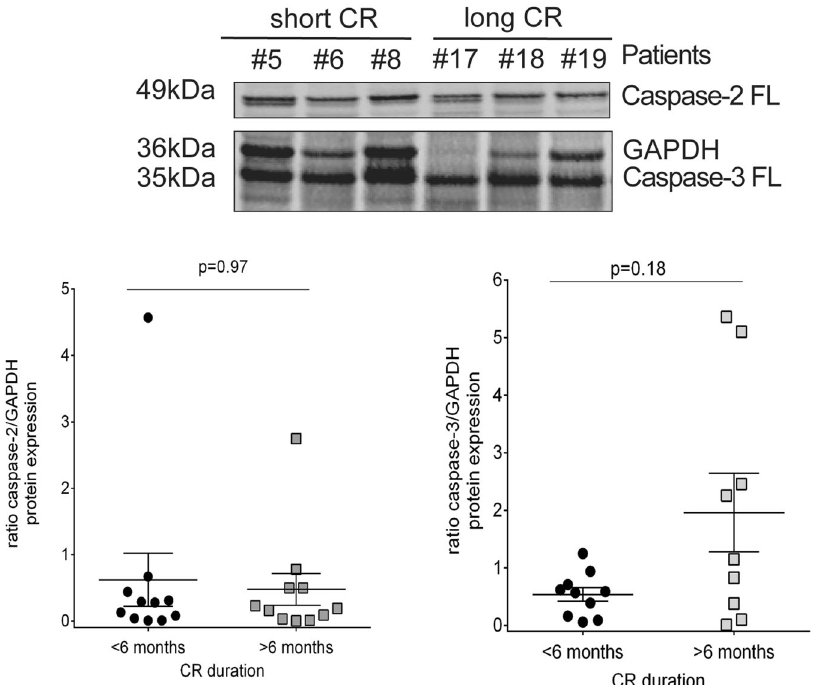
Fig. 5 Basal caspase-2 and caspase-3 protein levels are heterogeneously expressed and do not correlate to complete remission duration in AML patients. Primary treatment naïve AML mononuclear cells ( n = 22) were analysed for expression levels of full-length caspase-2 and full- length caspase-3 using immunoblotting. The samples illustrated in the top panel were all run on the same gel and the antibodies were run on the same membrane one at a time. Upper panel shows a immunoblot with full-length caspase-2 and full-length caspase-3 expressions in six patient samples with short (below 6 months) and long CR (above 6 months) respectively. GAPDH was used as loading control. Lower panels show the quanti fi cation of caspase-2 ( left ) or caspase-3 ( right ) expression levels in individual patients with short CR or long CR duration